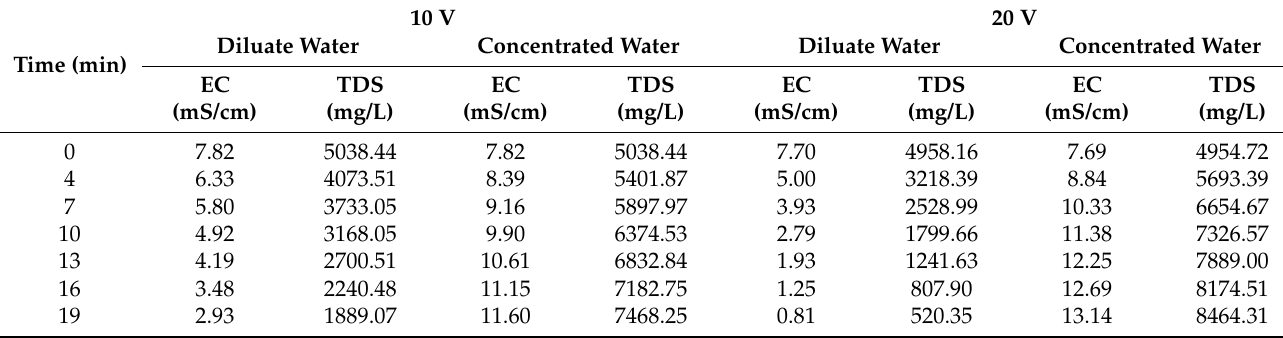
Table A5. Desalination results for the 5000 mg/L TDS sample at 30 ◦